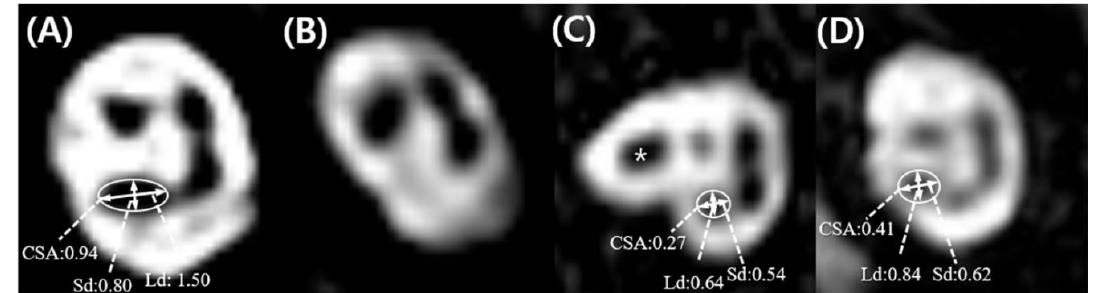
Figure 3. Parasagittal oblique images of the single-sided deafness ears, and the mean values of cochlear nerve size parameters according to cochlear nerve status. ( A ) Subject 2, ‘normal cochlear nerve (CN)’, where the CN is the optically larger than the facial nerve (FN). ( B ) Subject 9, ‘absent CN’ with no visible CN. ( C ) Subject 7, ‘small CN’ where the CN of the affected ear is optically smaller than the FN (asterisk) and the values of the long diameter (Ld), short diameter (Sd), and cross-sectional area (CSA) were all less than those corresponding to one standard deviation from the mean of normal ear (<1.06 mm for Ld; <0.79 mm for Sd; <0.71 mm 2 for CSA). In this figure, the continuation of the FN located anterosuperiorly in the midpoint of the IAC was observed ( D ) Subject 5, ‘indeterminate CN’,